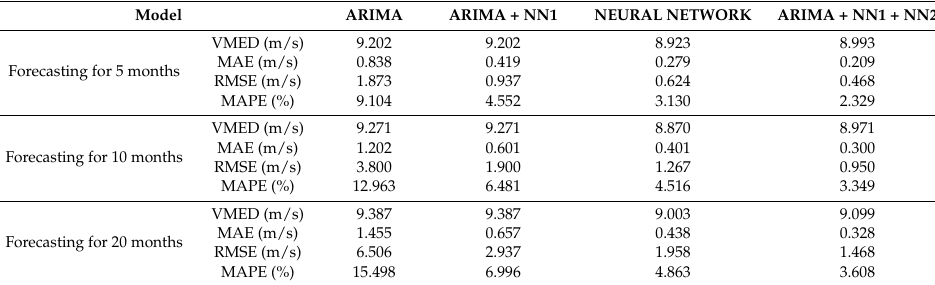
Table 7. Errors for multi-step forecast of speed for long-term